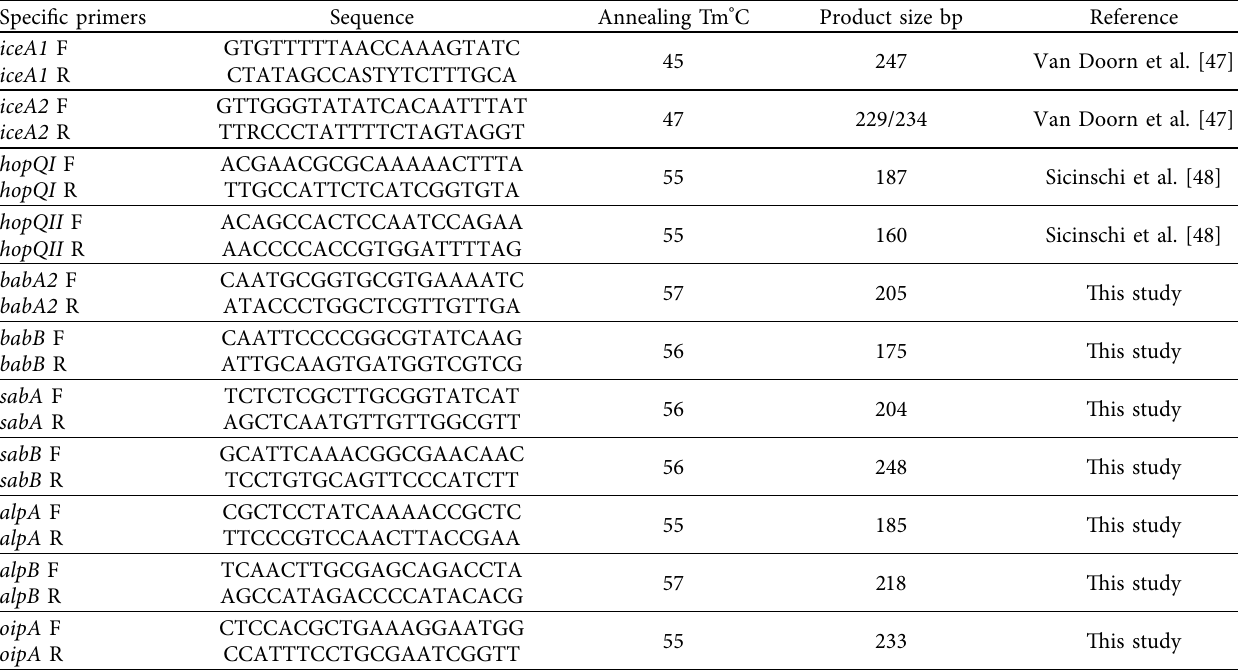
Table 2: Primers of H. pylori adhesins and surface proteins.